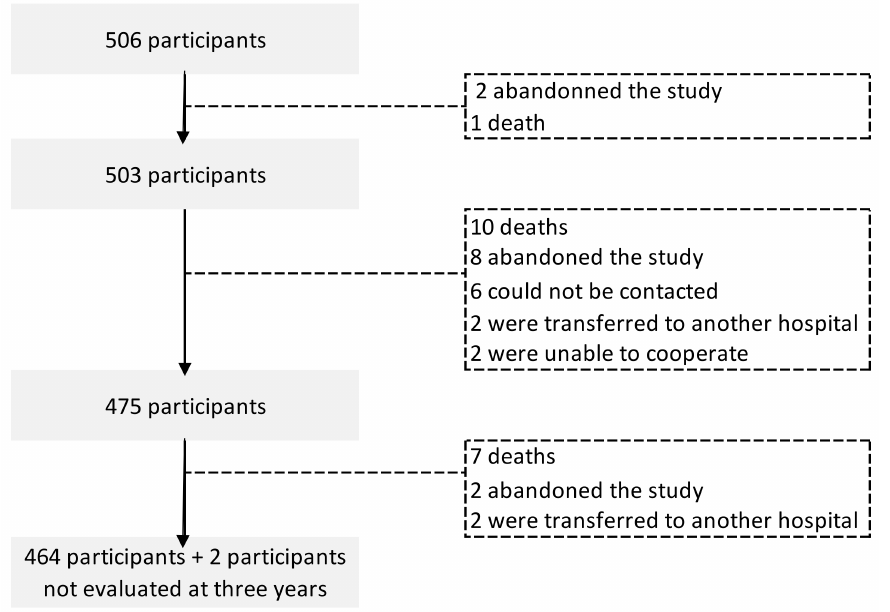
Figure 1. Flowchart describing the number of breast cancer patients in each of the follow-up